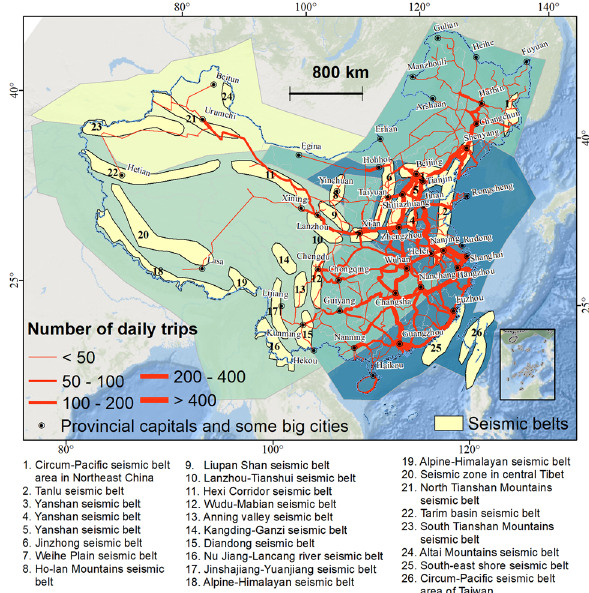
Fig. 3 Chinese railway network and the distribution of daily train trips,